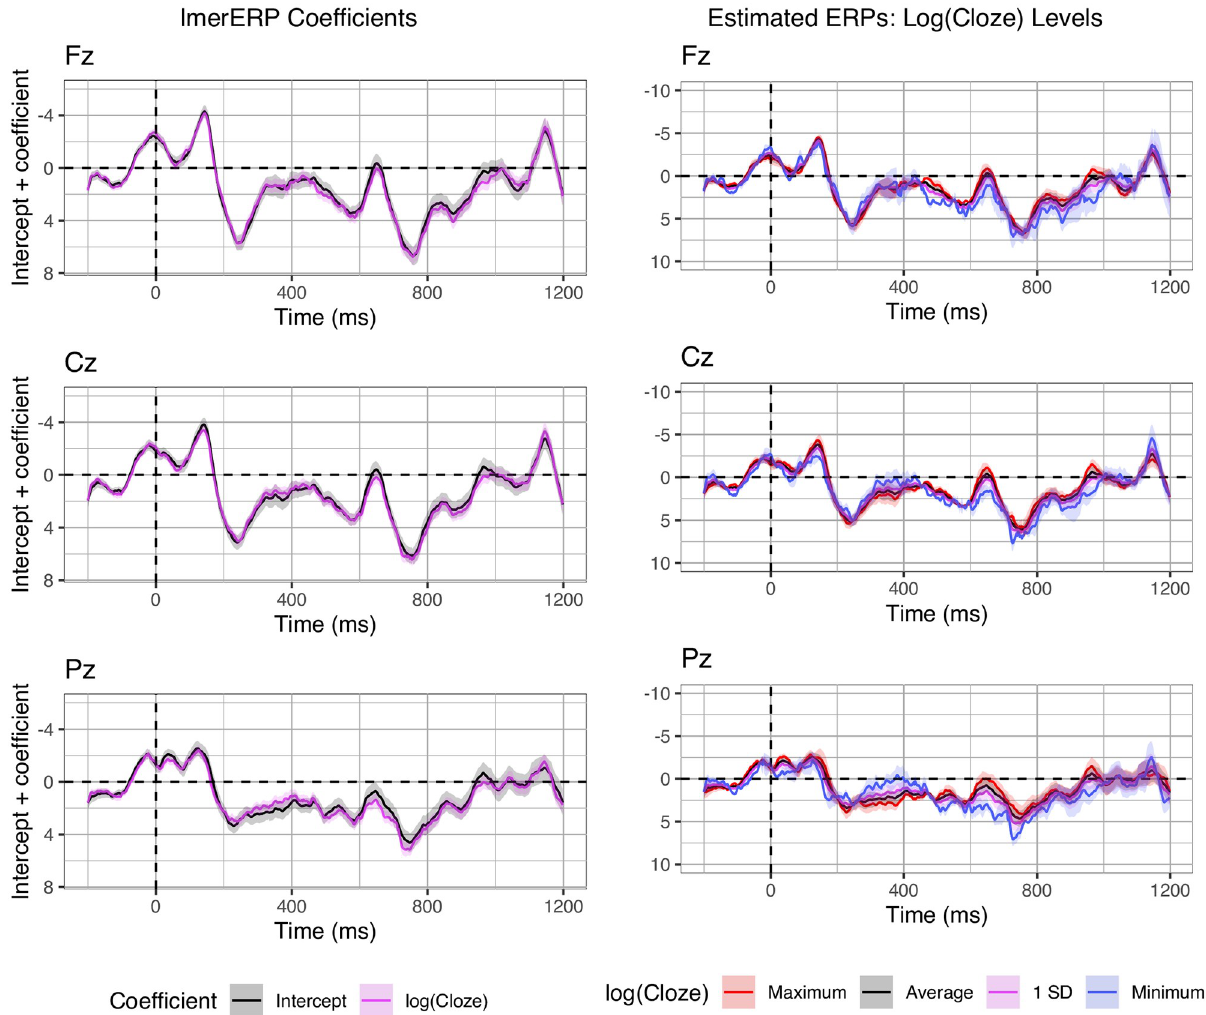
Fig 7. Exploratory analysis. Coefficients (left; added to their intercept) and estimated ERPs (right) for exploratory LMER models fitted only on Condition A. Error bars indicate the standard error on the coefficients from the statistical model (right) and standard error computed from the per- subject per-value averages